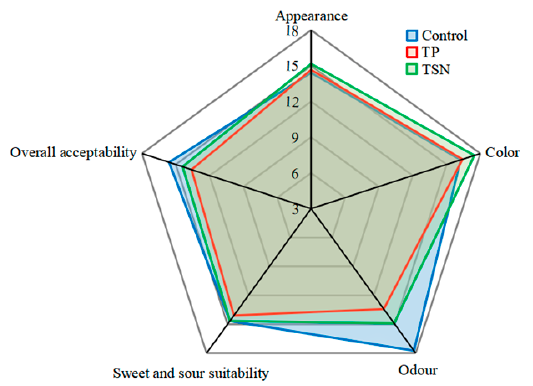
Figure 6. Spider plot of artificial sensory evaluation of orange juice under different sterilization treatments.